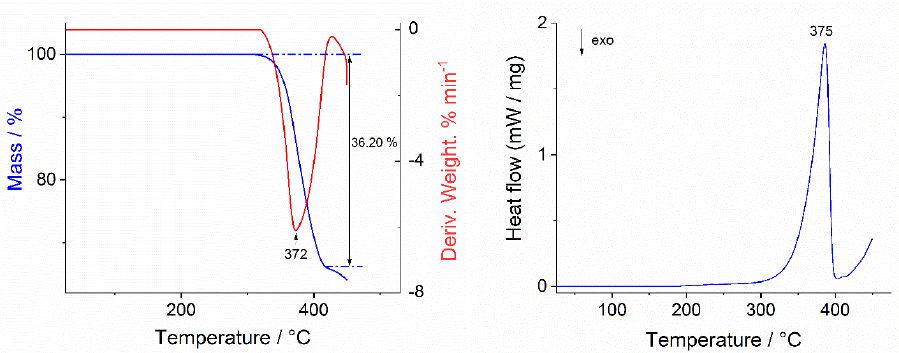
Figure 5. TGA and DTGA curves ( A ) and DSC ( B ) of 1 .